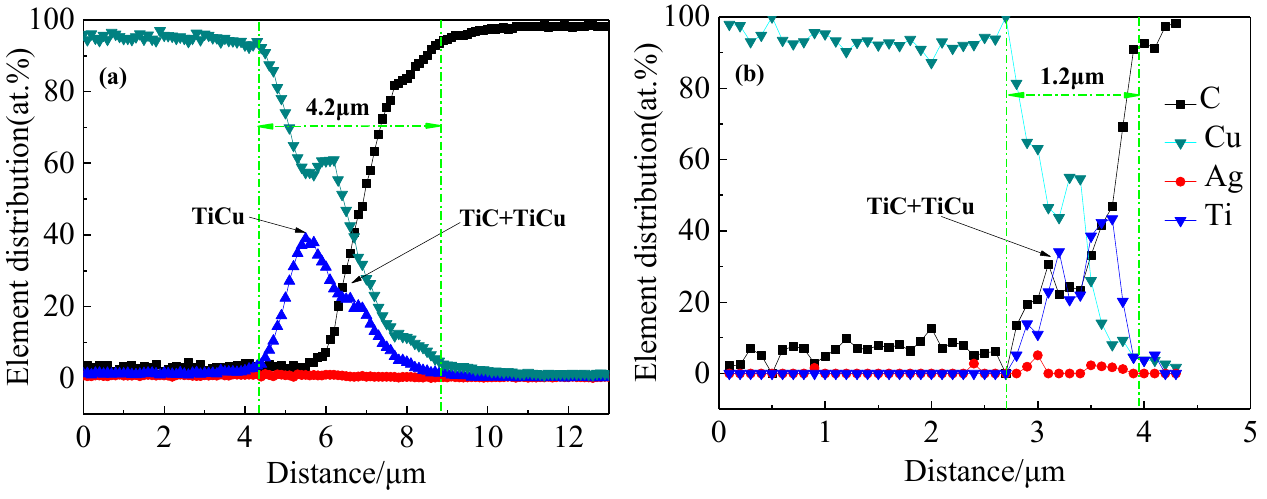
Figure 10. The results of EDS line-scan in the interlayer of welded joint with different Ti contents. ( a ) 6 wt.%, ( b ) 7.5 wt.%.